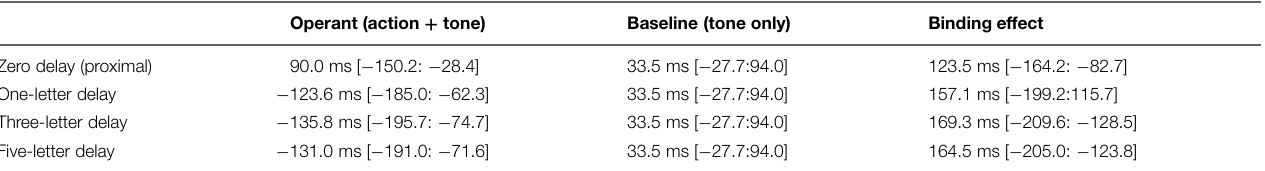
TABLE 4 | Reported occurrence of the tone for operant conditions and baseline condition, and the binding effect indicating the shift from baseline to operant condition, for all subjects.